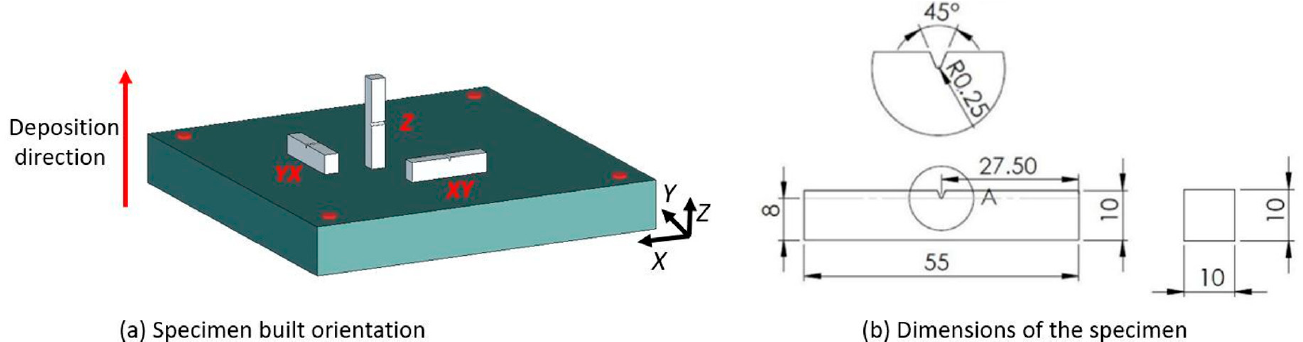
Figure 1. ( a ) An illustration of the V-notched Charpy impact toughness test specimen’s build orientation and ( b ) geometry with dimensions in mm as required by the ASTM E23. Unit: